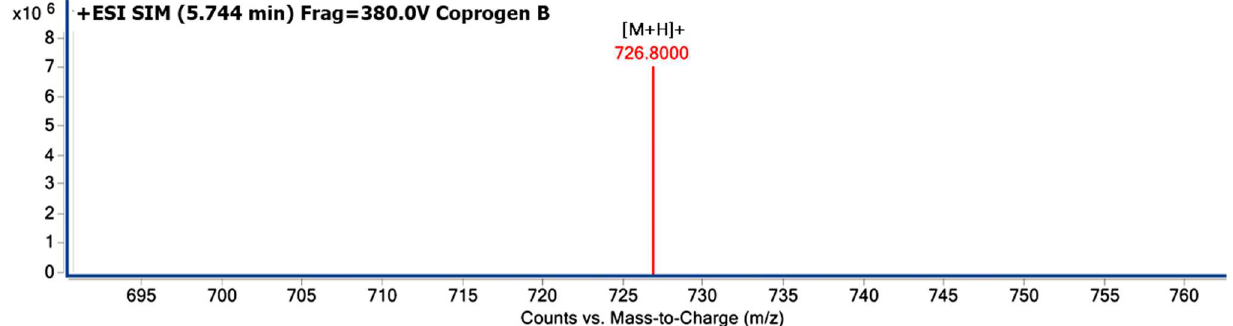
Figure 4. LC-MS chromatogram of the purified siderophore from the culture supernatant of T. marneffei ∆ sreA . These chromatograms show the mass spectra for iron-free siderophores in positive ion mode. The major peak (red) indicates that the molecular weight of the compound is 726.8000 m/z, [M+H] + .